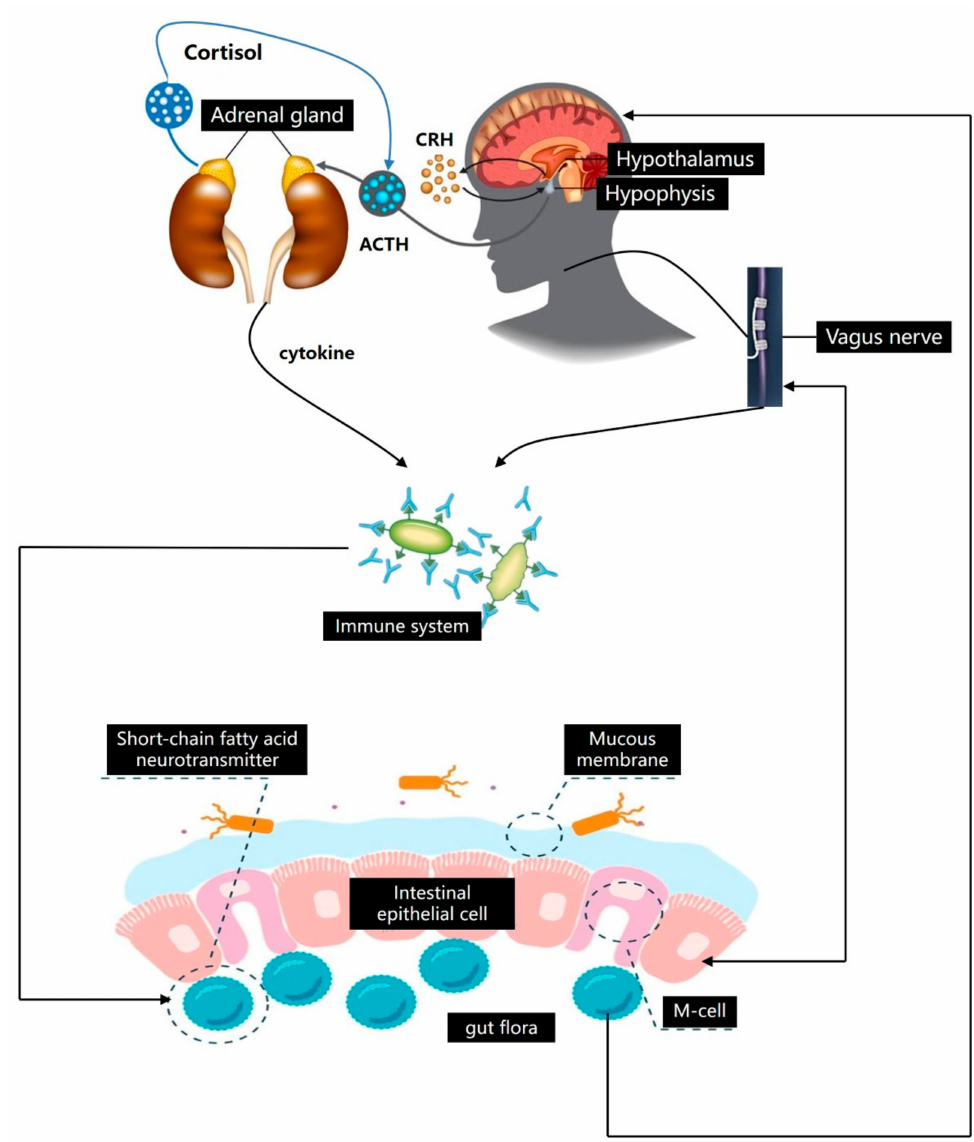
Figure 1. Microflora-regulation mechanism of brain–gut axis. The pathogenesis of depression mainly focuses on the hypothalamic–pituitary–adrenal axis, the monoamine neurotransmitter and receptors, the immune system, and the gut microbiota in the endocrine